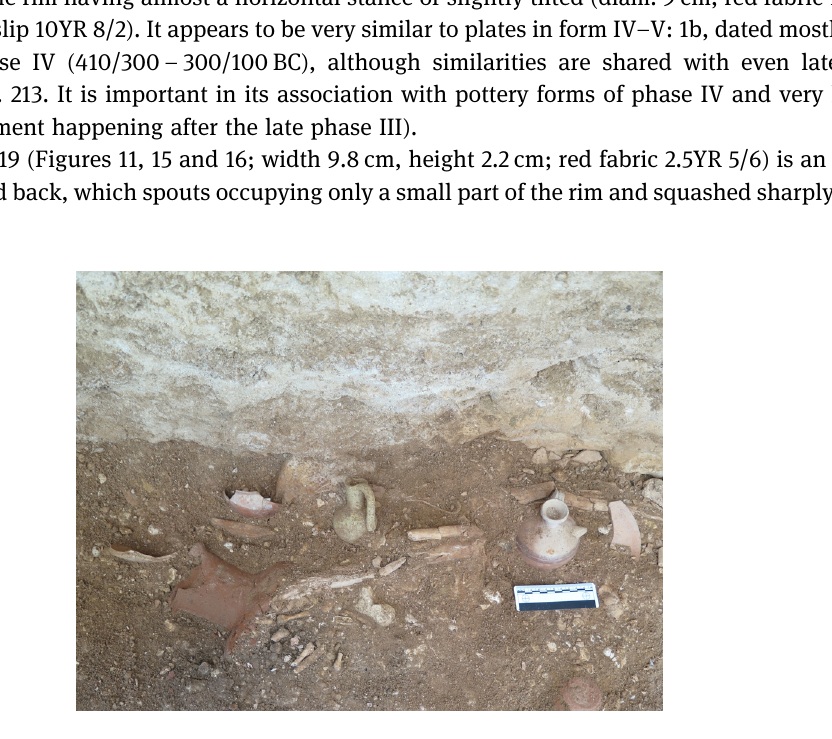
Figure 15: Details of Special Finds 12, 13 and 15 in intermediate phase II, and partial uncovering of Special Find 14 in early phase